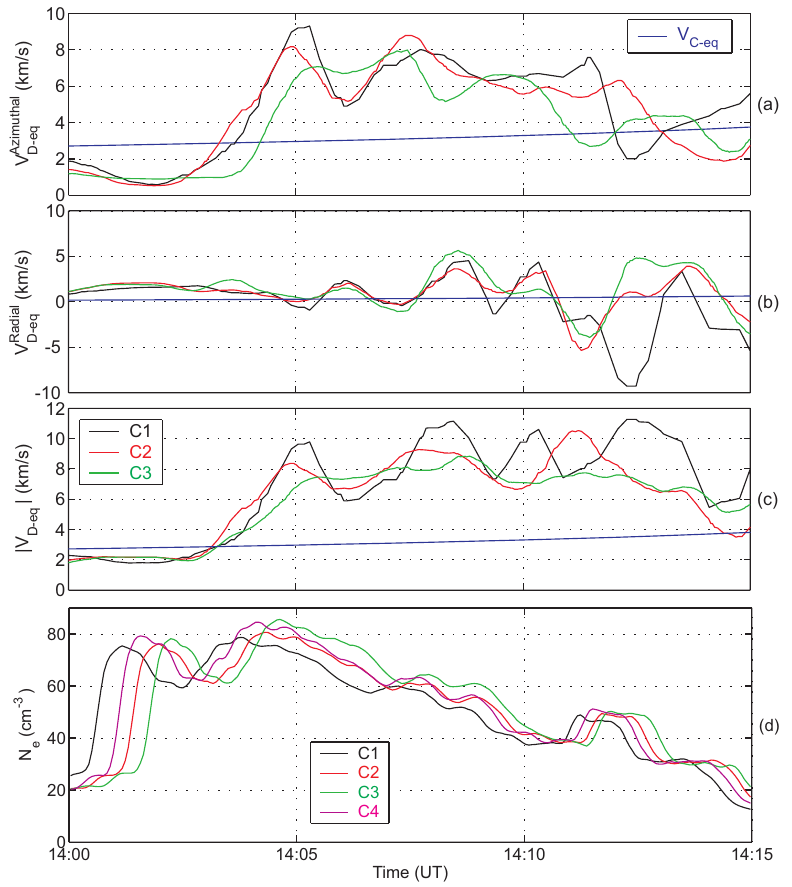
Fig. 12. Similar as Fig. 11 during the outbound plume crossing of 2 June